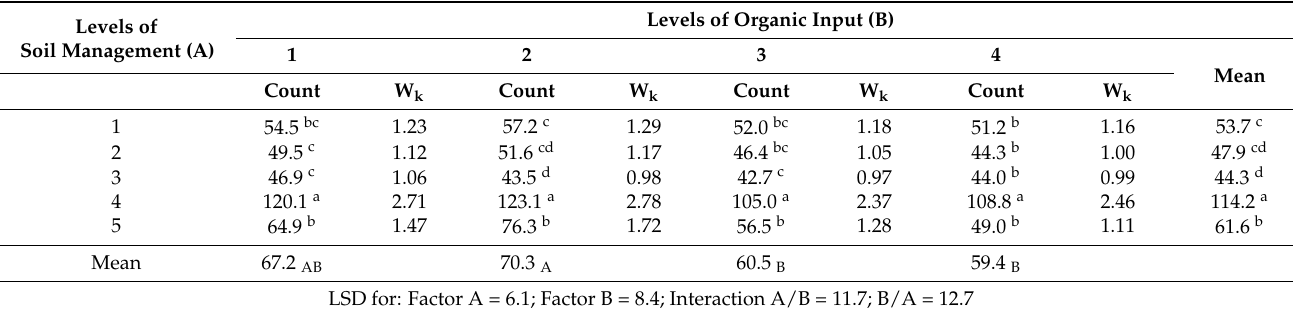
Levels of Organic Input (B)